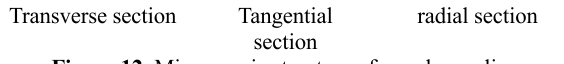
Figure 12 . Microscopic structure of wood sampling